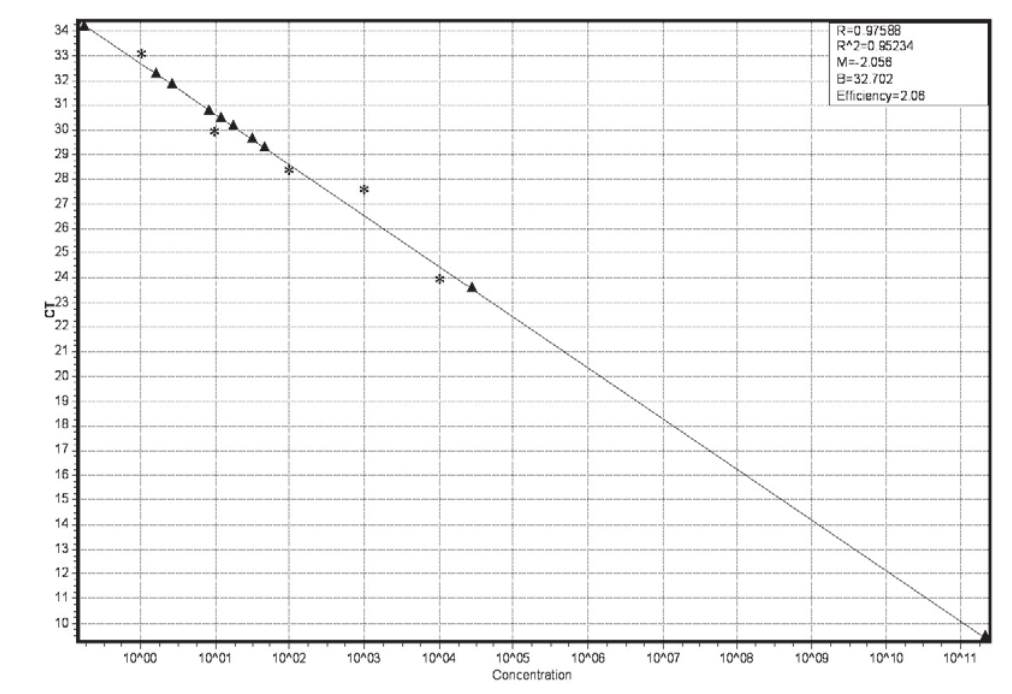
Fig. 3. Standard curve for the quantitative PCR (TaqMan ® ) assay for the quantification of P. chlamydospora in DNA samples extracted from 2003 wash water samples. *, standards; (cid:1) unknown test samples.